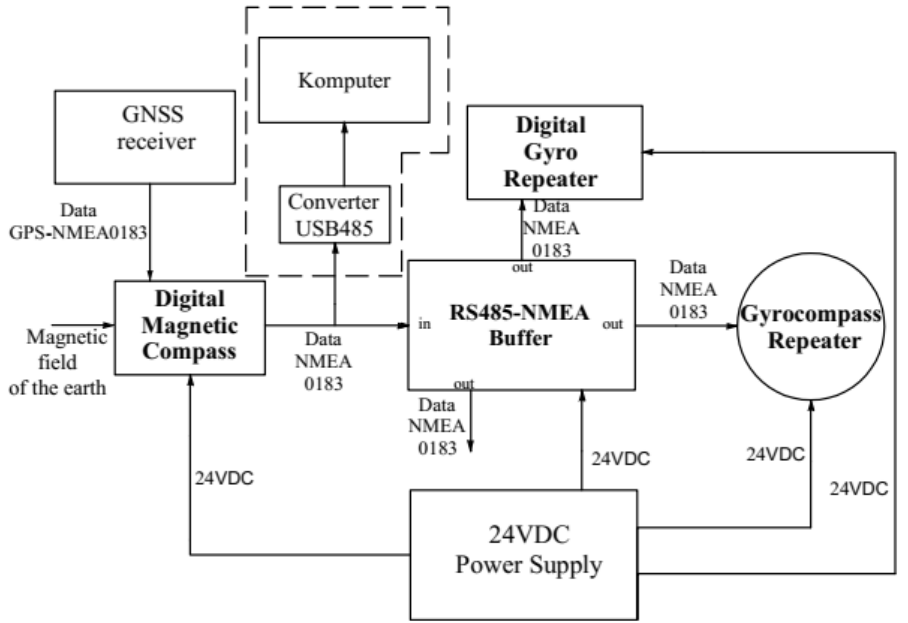
Fig. 1. Block Diagram of the Digital Magnetic Compass